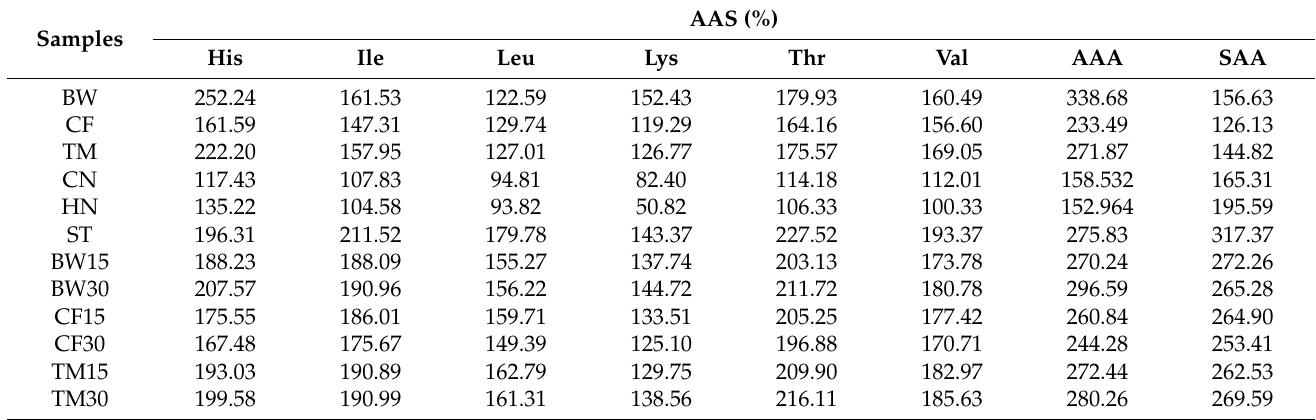
Table 3. Nutritional value of the protein of raw materials and enriched products.